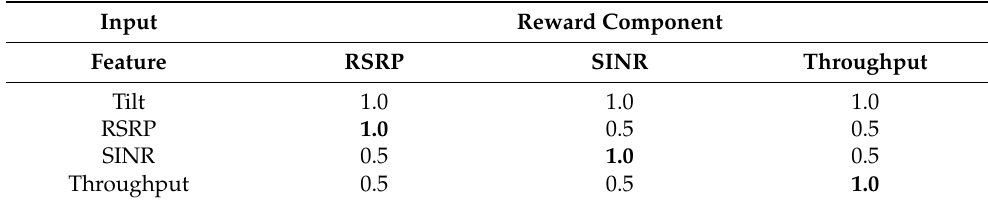
Table 3. Relevance table configured by the user quantifying the desired